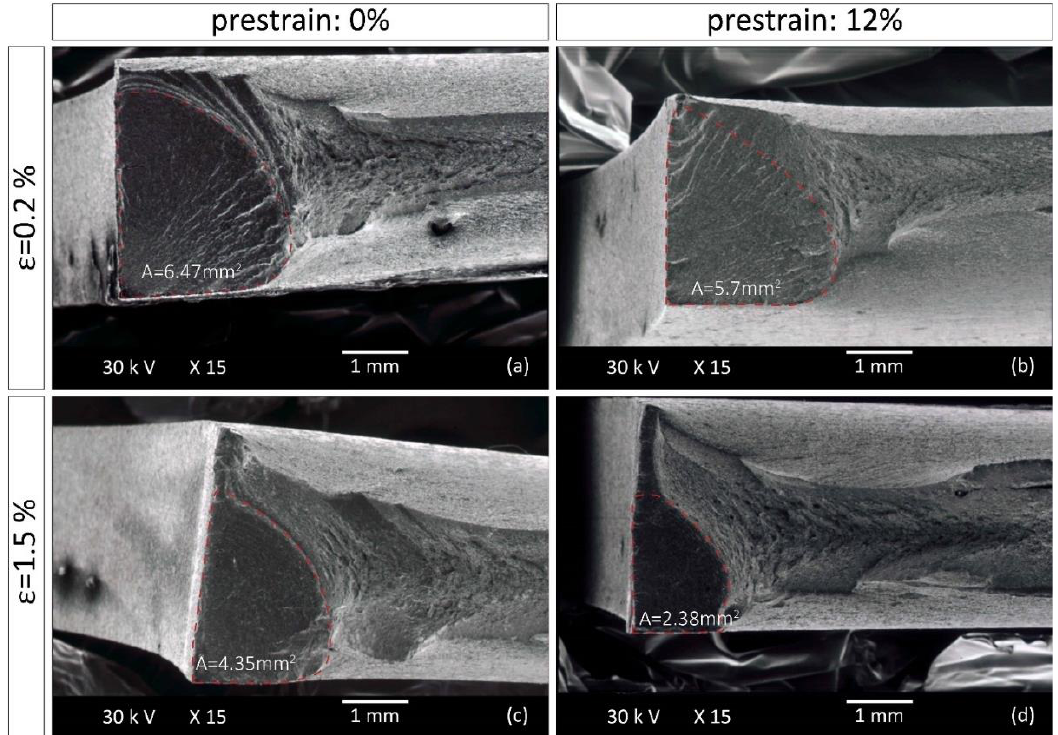
Figure 8. Fatigue section size of fractured S355MC specimens in ( a ) reference and ( b ) 12% pre- strain condition that have been subjected to 0.002 strain amplitude, and in ( c ) reference and ( d ) 12% pre-strain condition that have been subjected to 0.015 strain amplitude.